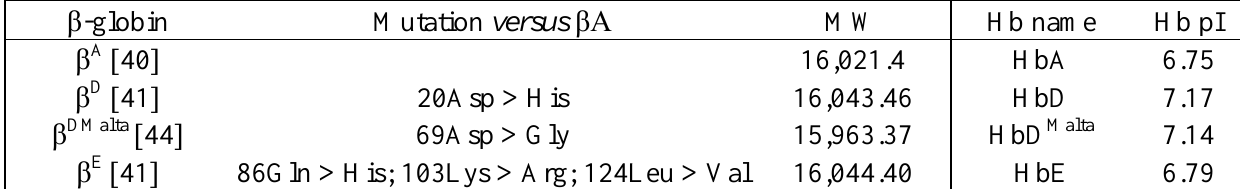
Table 3. Charged variants at the HBB locus in goats and corresponding hemoglobins with related molecular weight (MW) and isoelectric points